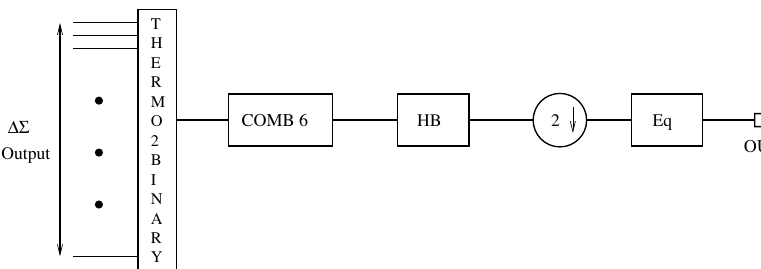
Figure 4. Block diagram of the decimation